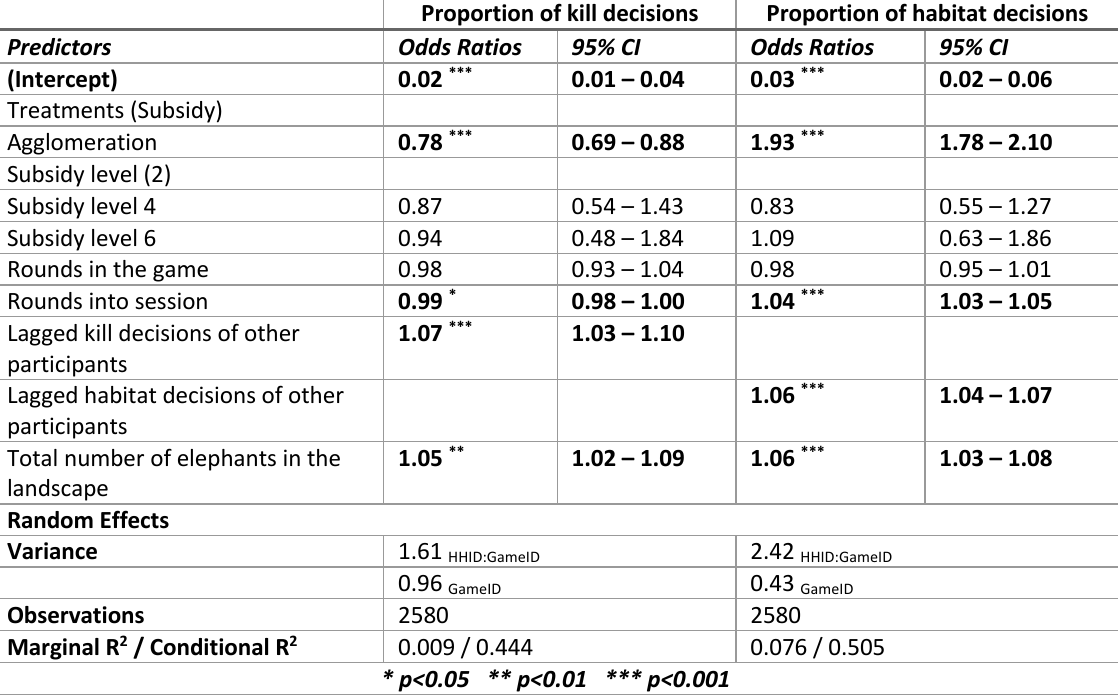
Table A1.7: Robustness tests: Odds ratio estimates from three GLMM models showing the effect of treatments and three variables of interest (1: Equity, 2: Region ID, 3: positive well-being impacts of elephants) on farmers’ propensity to kill elephants in the games. Random effects included in the model were individuals and